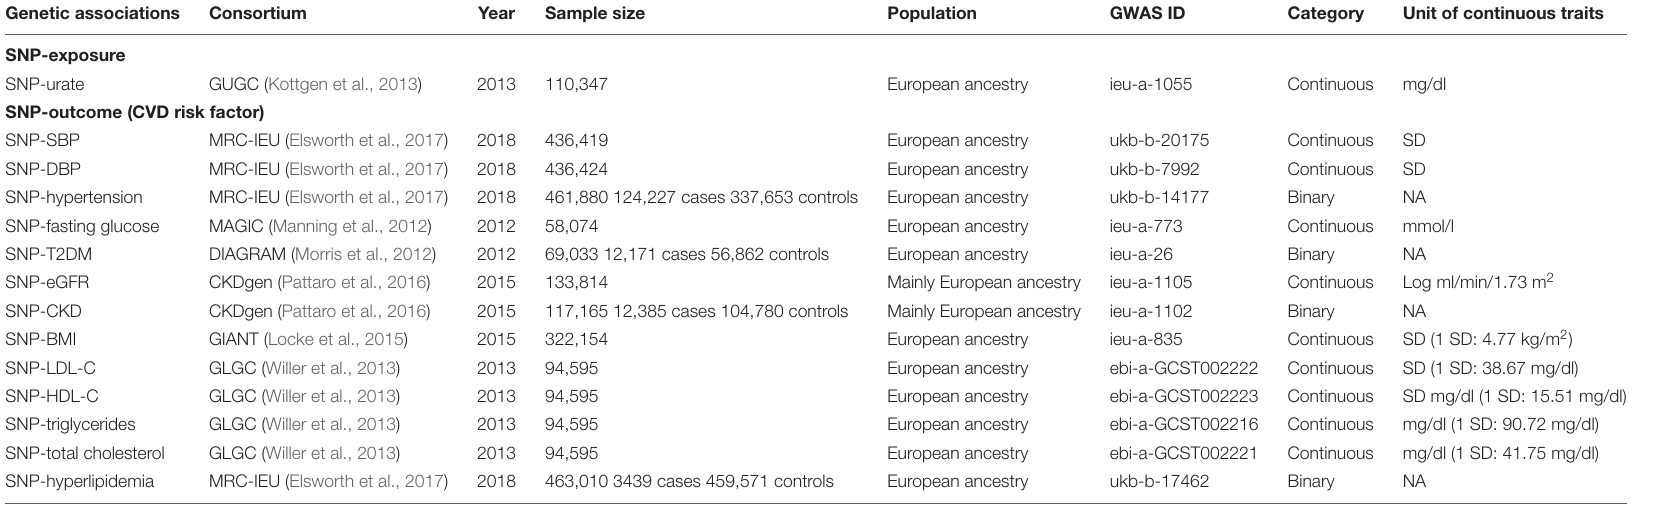
TABLE 1 | Characteristics of data sources. Genetic